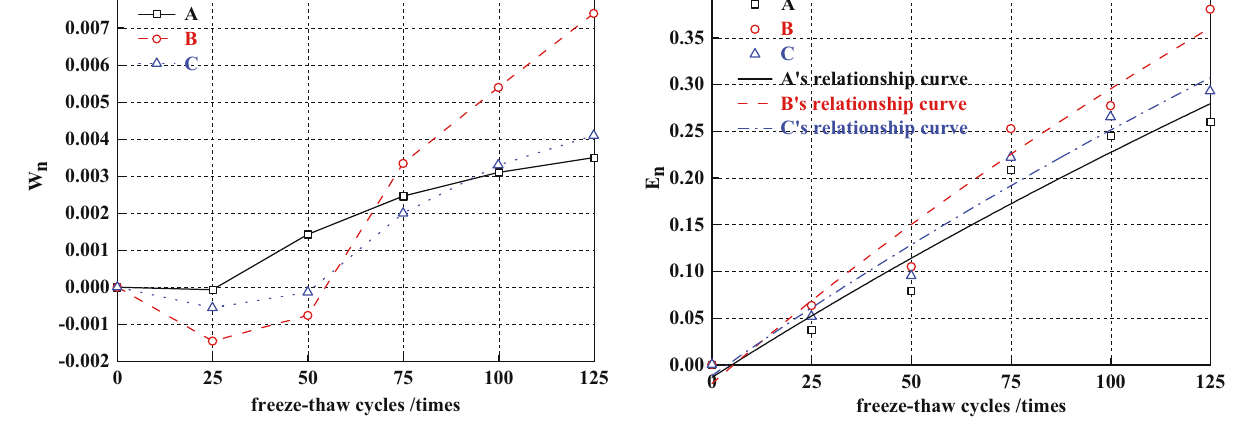
Figure 8: Relationship between W n and freeze – thaw cycles. Figure 9: Relationship between E